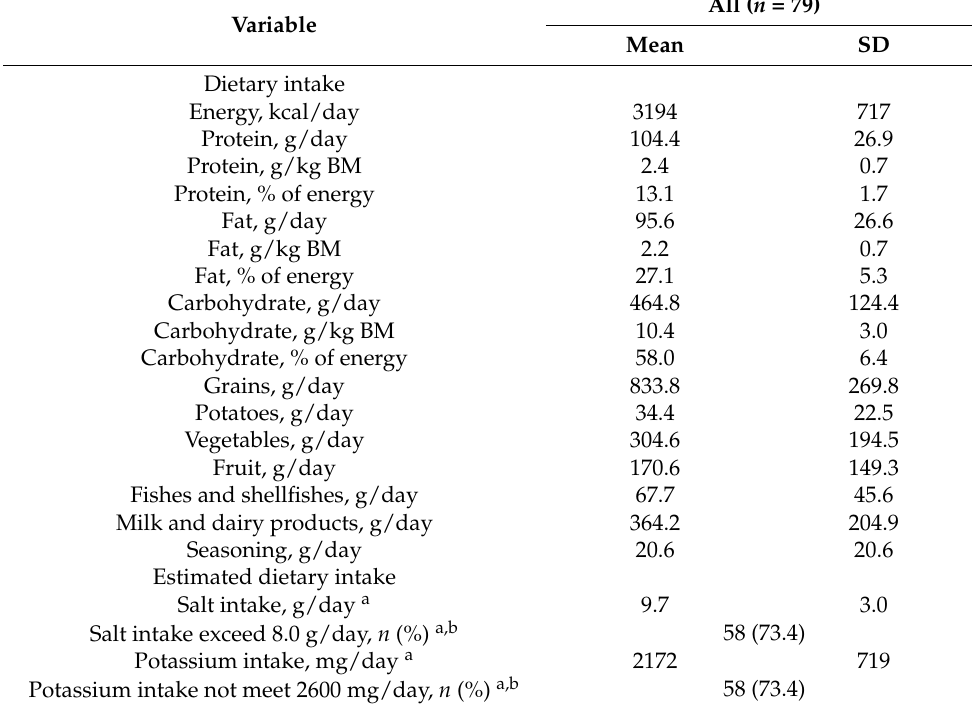
Table 3. Dietary intake and estimated dietary intake of the study